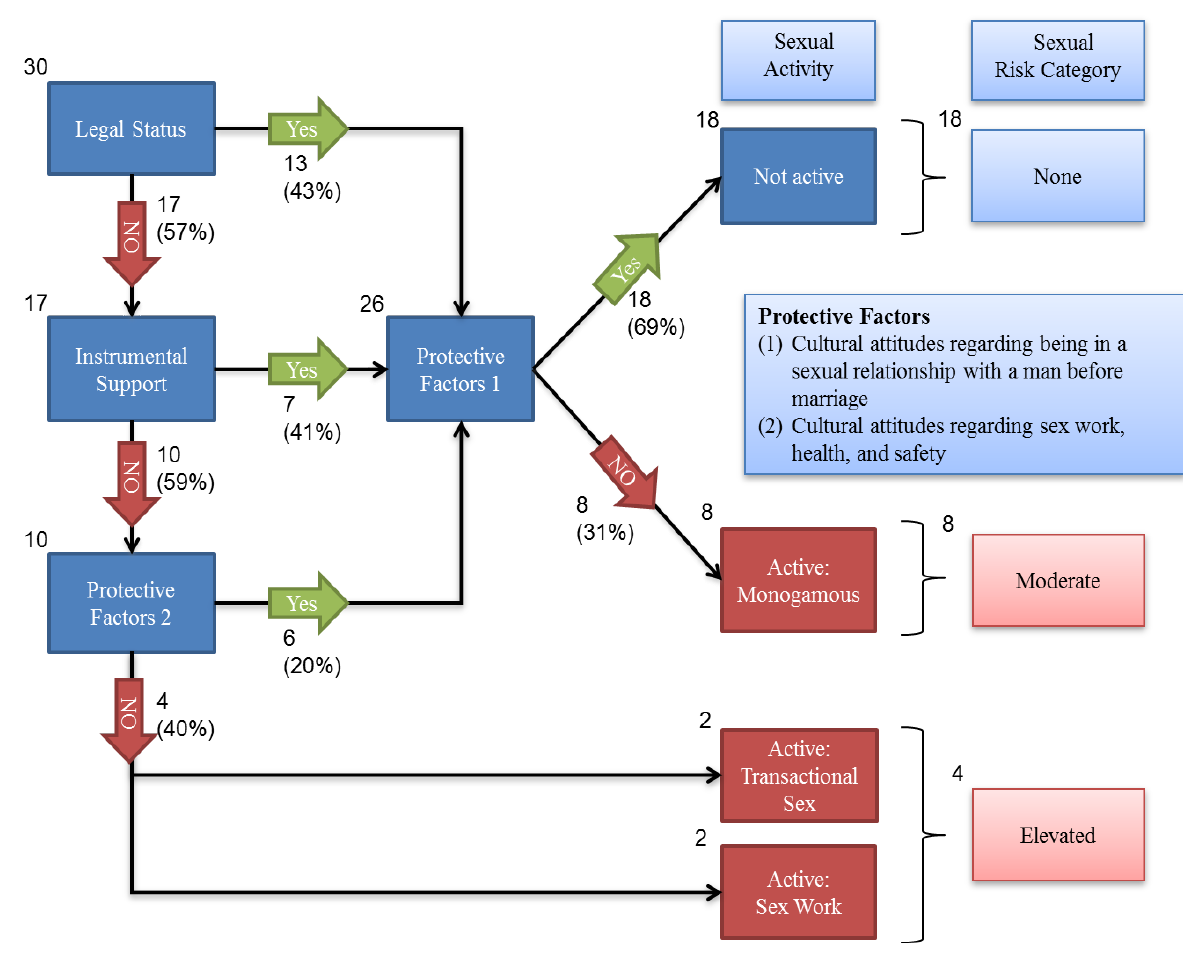
Figure 1: Hypothesized Pathways Involving Socio-Structural Barriers and Protective